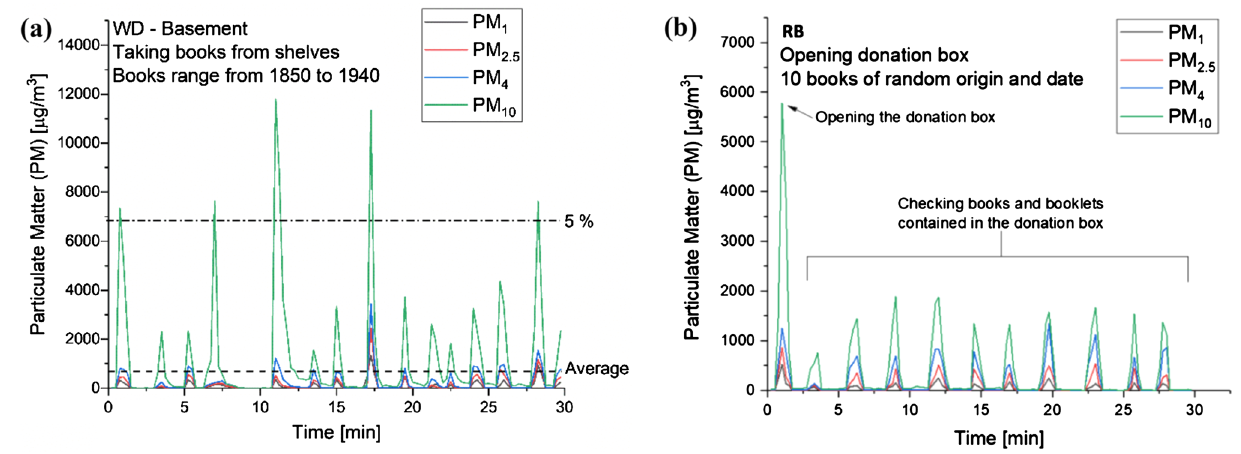
Fig. 1 Examples of real-time measurements of PM of different sizes (PM , PM , PM , and PM have a diameter lower than 1, 2.5, 4, and 1 2.5 4 10 10 µm, respectively). The example in a represents the activity of “taking books from shelves” measured in storage room 1, located